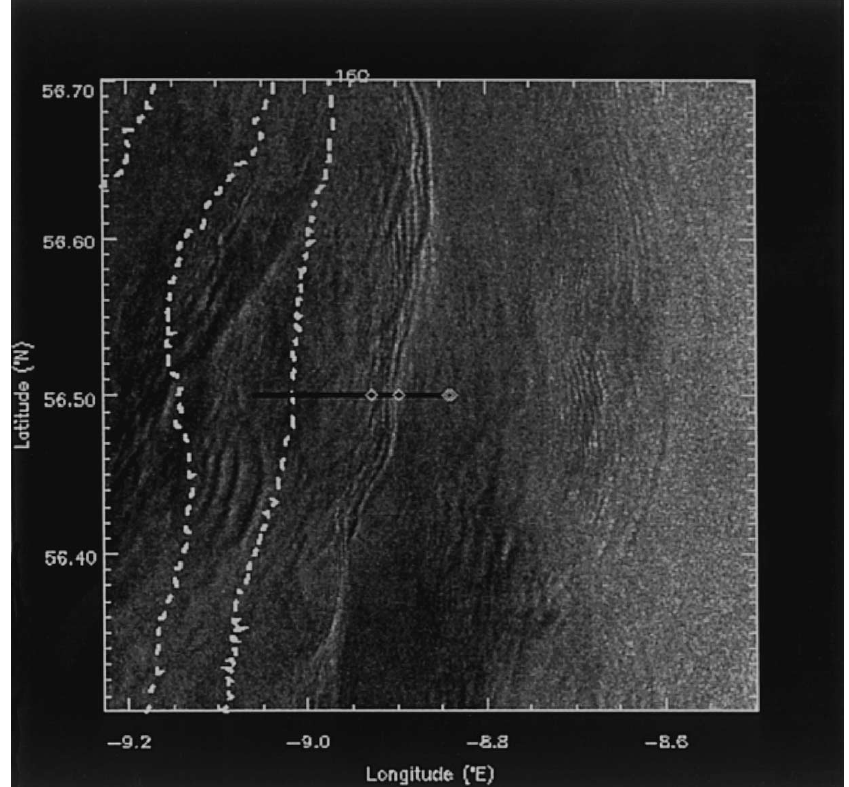
Fig. 17. ERS-2 SAR image from 1136 UTC, 21 August, 1996, showing the SESAME region. Bathymetry contours are marked as white dashes , for 160 m, 600 m and 1000 m, from right to left . Also marked is the survey track from Fig. 3, with diamonds marking the positions of the leading edge of the internal bore feature during the four surveys (surveys 3 and 4